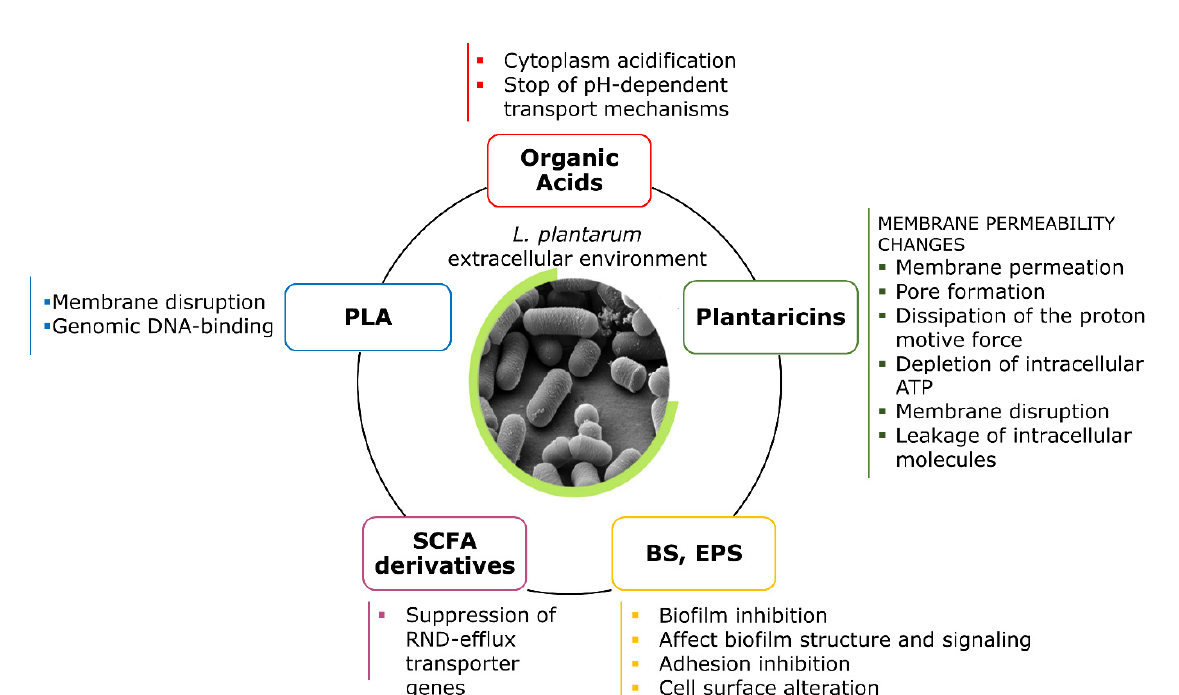
Figure 3. Different chemical nature of the principal antimicrobial agents produced by L. plantarum strains, and the suggested mechanisms underlying their antimicrobial effect. PLA: phenyl lactic acid; SCFA: short-chain fatty acids; BS: biosurfactants; EPS: exopolysaccharides.